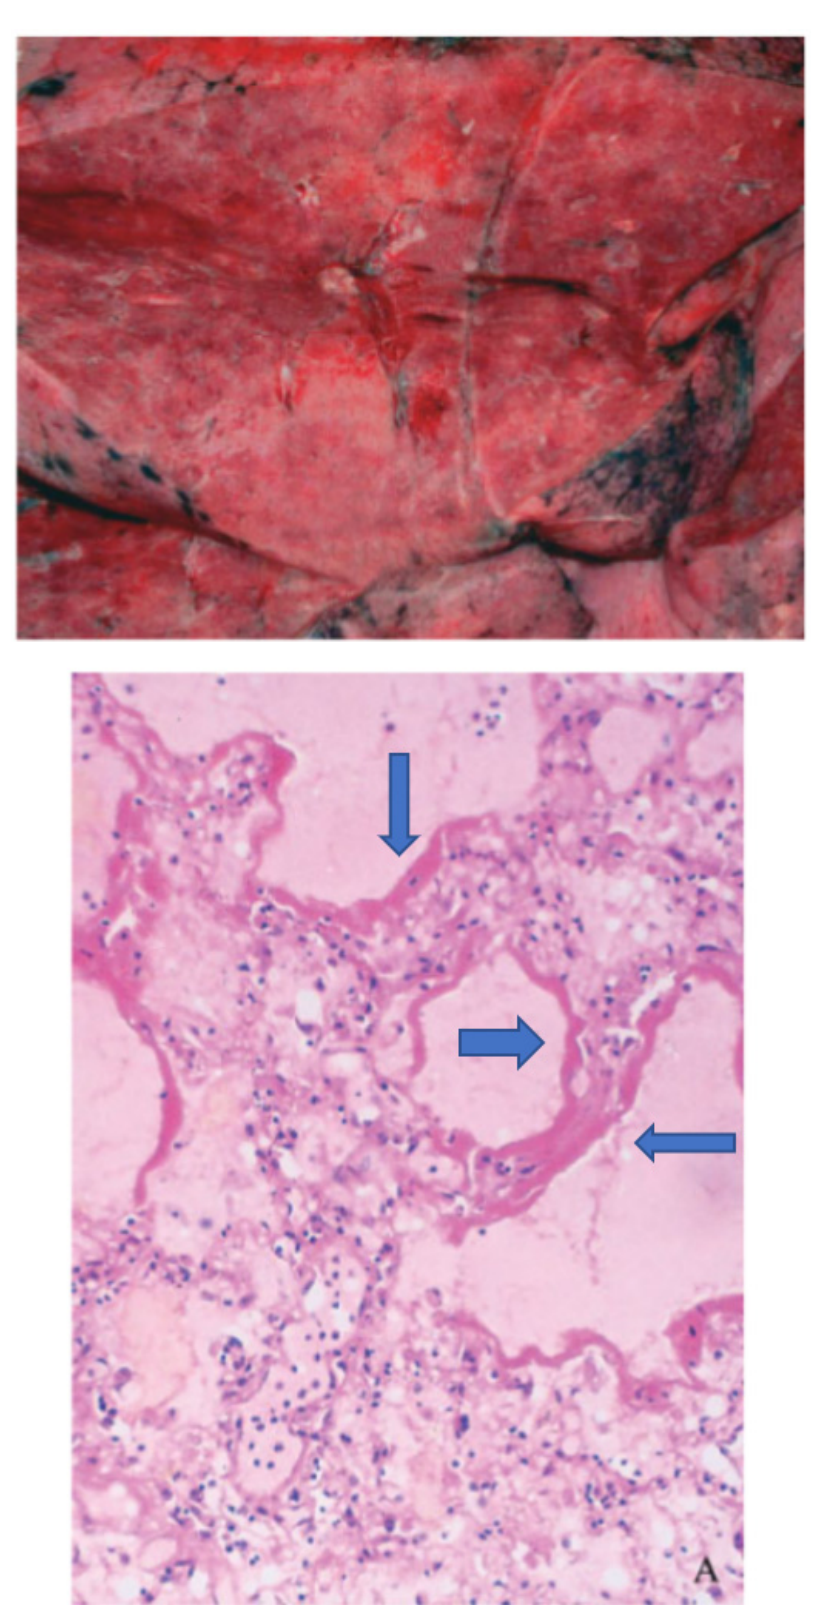
Figure 2. Gross morphology (upper panel) from the lung of a patient who died after a SARS-CoV- 1- infection shows a congested lung while the histology picture (lower panel) shows the hyaline membranes (blue arrows). Modified from Ding et al. [173].